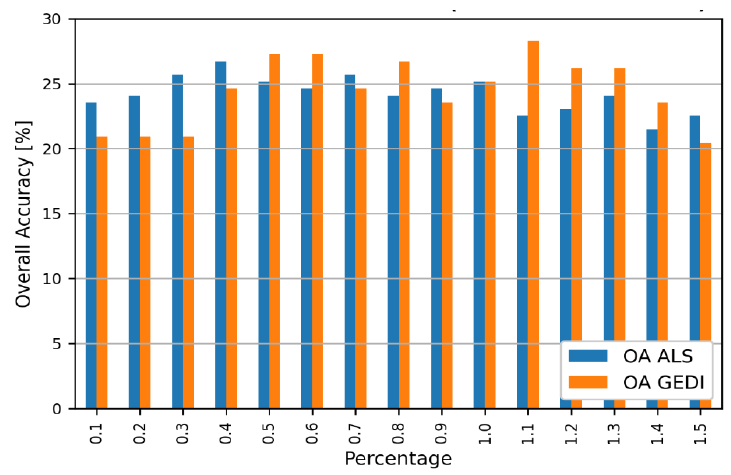
Figure 8. OA values for BDA approach using different thresholds. Table 1. Confusion matrix of EBA for NoL calculation, with ALS input data (UA = user accuracy; PA = producer accuracy; OA = overall accuracy).